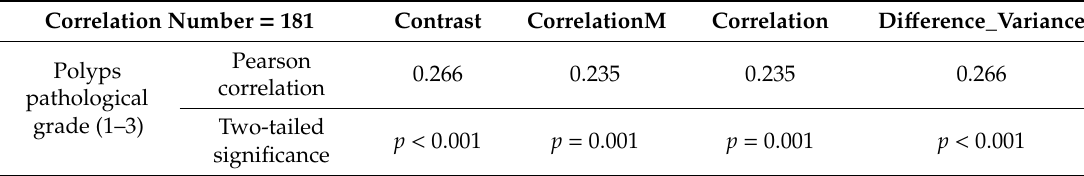
Table 6. Summary of GLCMs and other pathological